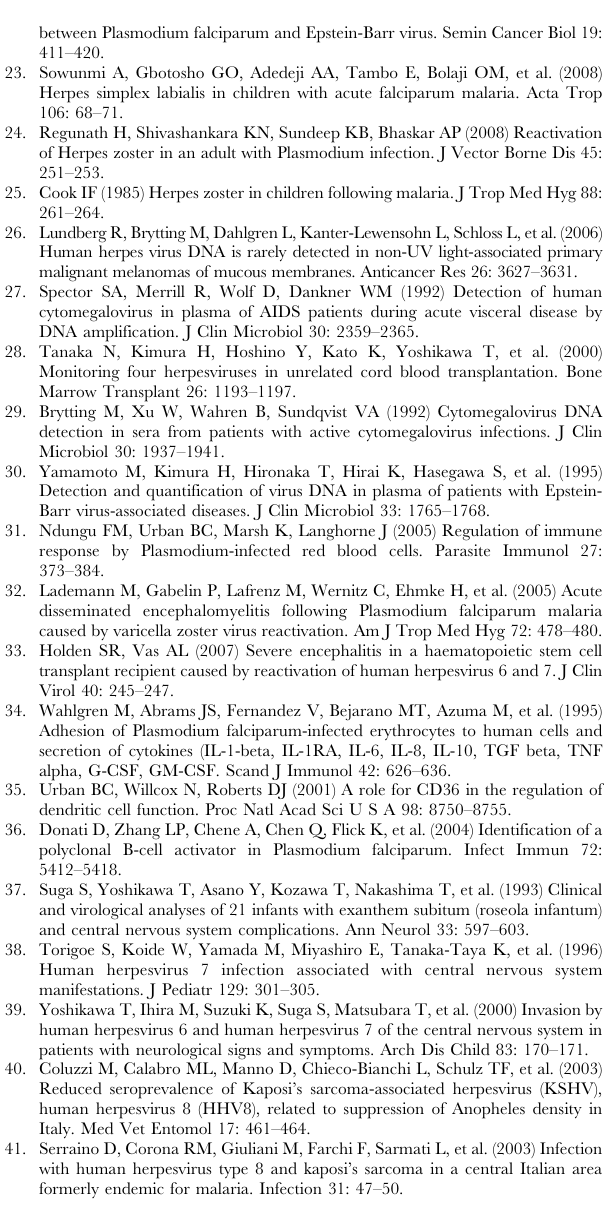
considered negative (0). ‘‘ 2 ‘‘indicates that the data are not